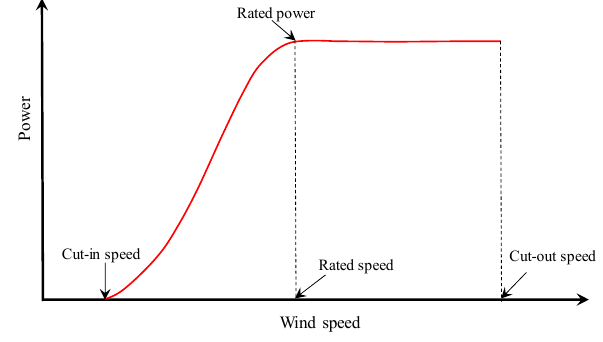
Figure 4. Typical wind power output versus wind speed.